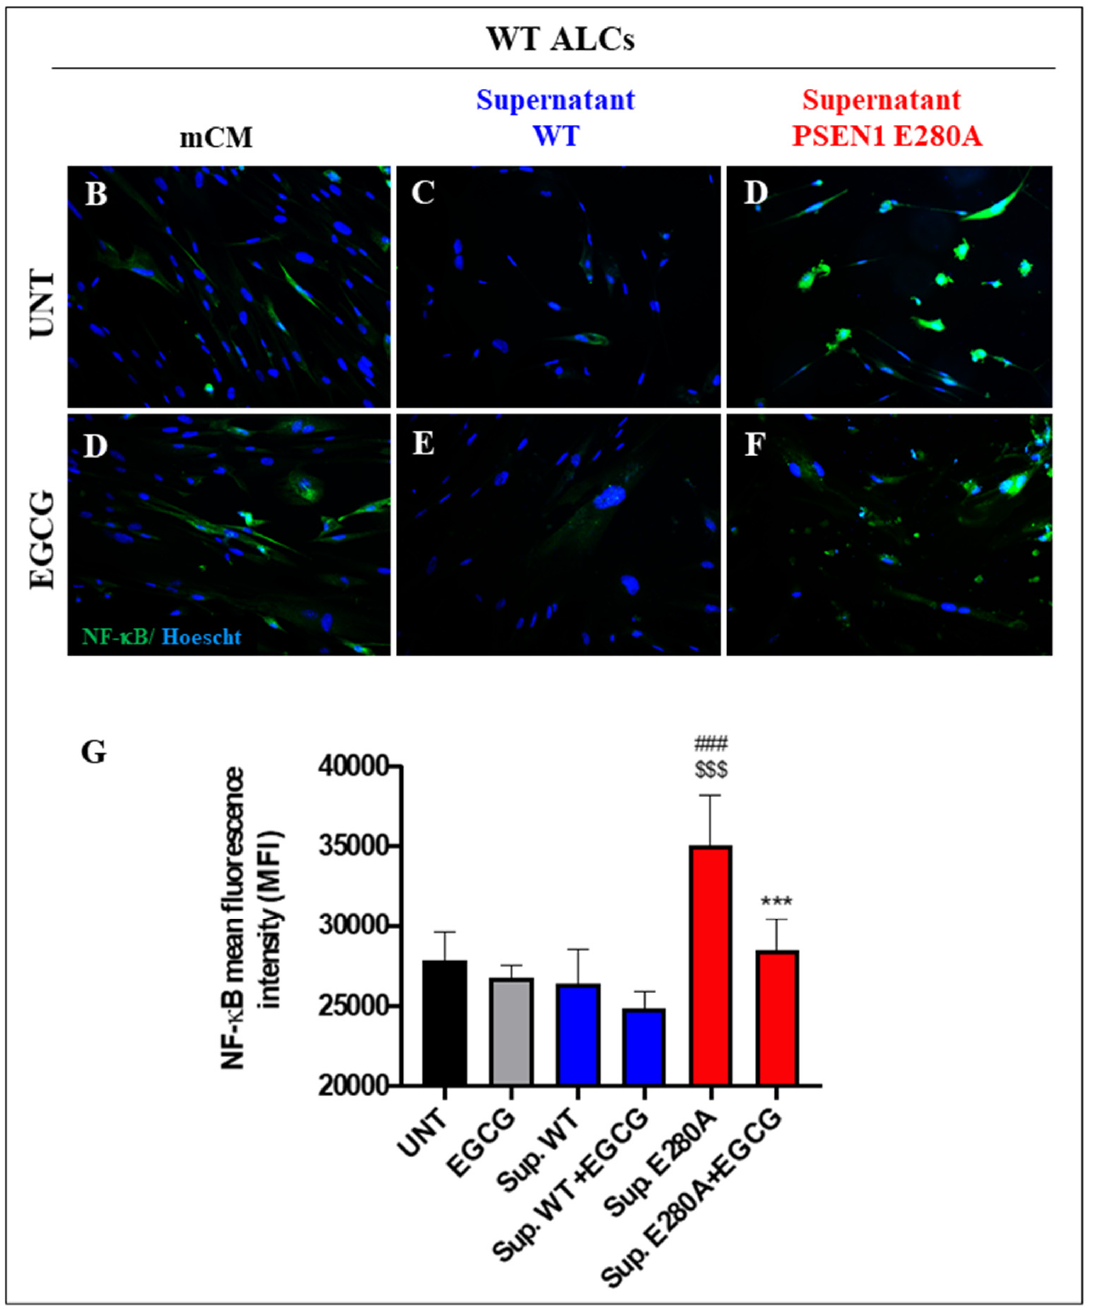
Figure 7. The PSEN1 E280A culture supernatant induces secretion of a proinflammatory molecule (IL-6), and activation of NF- κ B in astrocyte-like cells (ALCs). ( A ) After 7 days of transdifferentiation of MenSCs, ALCs were exposed to either mCM, WT supernatant, or PSEN1 E280A culture supernatant for 4 days in the absence (untreated, UNT) or presence of EGCG. Then, supernatants were collected and used to determine IL-6 levels according to the described method. The levels of IL-6 were normalized to the cell protein concentration. ( B ) After 7 days of transdifferentiation of MenSCs, ALCs were exposed to either mCM, WT supernatant, or PSEN1 E280A culture supernatant for 4 days in the absence (untreated, UNT) or presence of EGCG. Then, cells were labeled with primary antibodies against NF- κ B, and fluorescent secondary antibodies. The nuclei were stained with Hoechst 33342. Representative merged images of ALCs exposed to mCM ( B , D ), WT supernatant ( C , E ), and PSEN1 E280A culture supernatant ( D , E ) without ( B – D ) or with EGCG ( D – F ). ( G ) Quantification of NF- κ B fluorescence intensity. Data are expressed as the mean ± SD; ###, *** , $$$ p < 0.001; *** represents differences compared to Sup. E280A; ### represents differences compared to UNT ALCs; $$$ represents differences compared to Sup. WT. The histogram and figures represent 1 out of 3 independent experiments. Image magnification, 200 ×